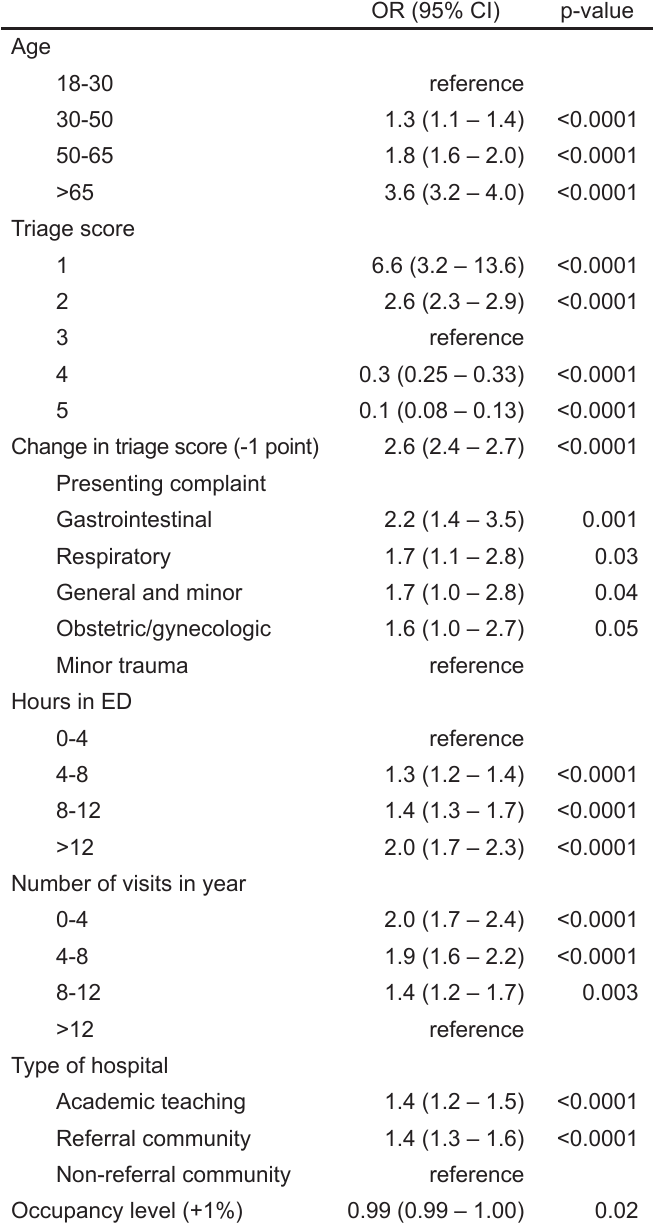
Table 4. Factors associated with URVA in logistic regression